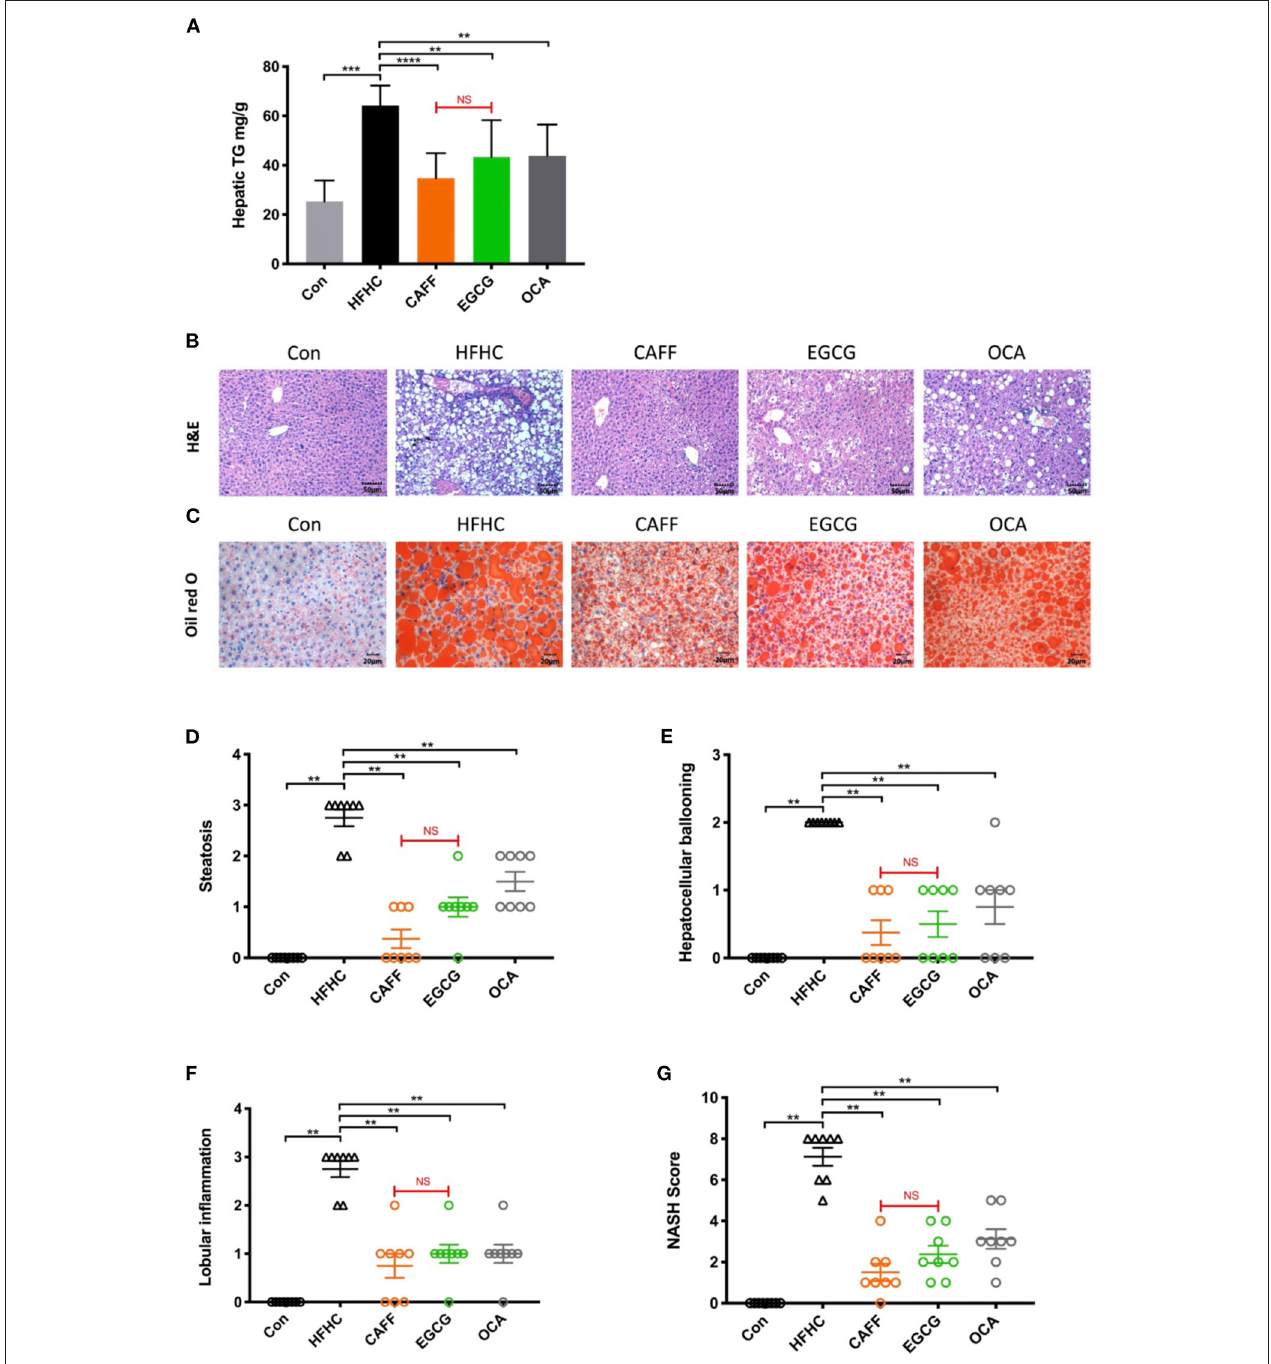
FIGURE 4 | Caffeine and EGCG markedly ameliorate hepatic steatosis and inflammation in non-alcoholic steatohepatitis mice. (A) Hepatic TG content in mice ( n = 8). (B) H&E and (C) Oil Red O staining for liver sections (200 × ). (G) The NAS was calculated as a sum of the scores of three parameters [steatosis (D) , hepatocellular ballooning (E), and lobular inflammation (F) ] vs. HFHC, ** P < 0.01, *** P < 0.001, **** P < 0.0001; vs. EGCG, NS, not significant. mice had F1-F2 stage fibrosis ( Figure 5D ). The positive staining caffeine and EGCG groups were similar to that in the Con group area of fibrosis in the HFHC group was significantly higher ( Figure 5E than that in the Con group, which was consistent with the pathological findings. The positive staining areas of fibrosis in the